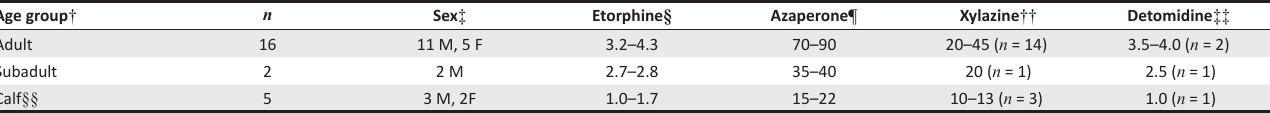
TABLE 1a: Immobilising drug combinations and doses used for free-ranging black rhinoceros in Zimbabwe. Doses (in mg) for black rhinoceros immobilised with etorphine, azaperone, and xylazine or detomidine. Age group † n